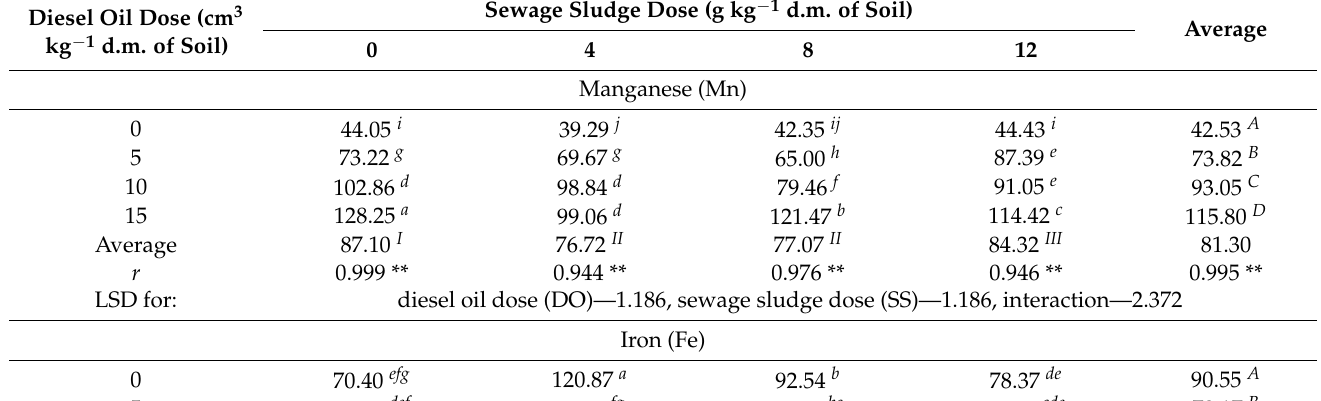
Table 4. Content of manganese (Mn), iron (Fe) and cobalt (Co) in aboveground parts of oat— Avena sativa L. (mg kg − 1 d.m.). Diesel Oil Dose (cm